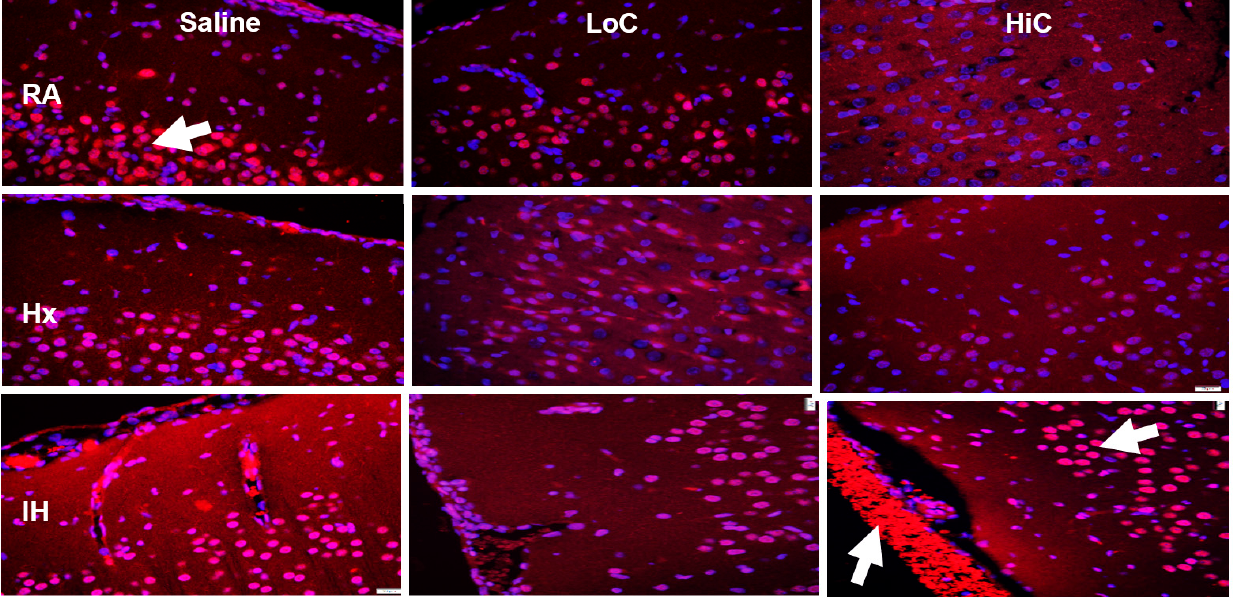
Figure 8. Representative adenosine A2A receptor (A 2A R) immunofluorescence staining in the cerebral cortex at P14. Groups are as described in Figure 1. Images are 20× magnification, bar scale is 50 µm. A 2A R was induced in the placebo saline group exposed to neonatal IH, suppressed with LoC in all oxygen environments, and induced with HiC in neonatal IH (arrows). HiC in IH also had severe hemorrhage (arrow).